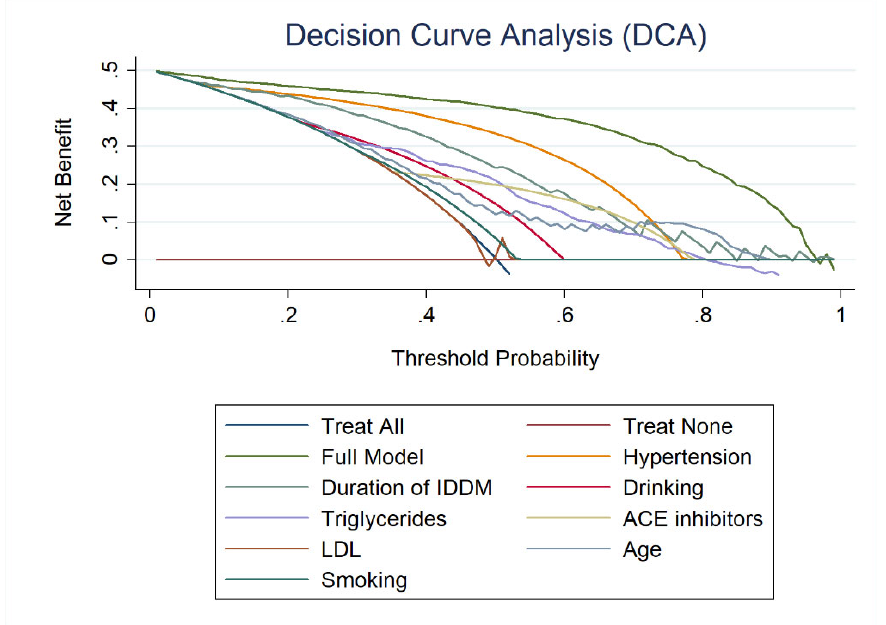
Figure 5. Decision curve analysis (DCA) of the top 8 ranked features for predicting the CKD.